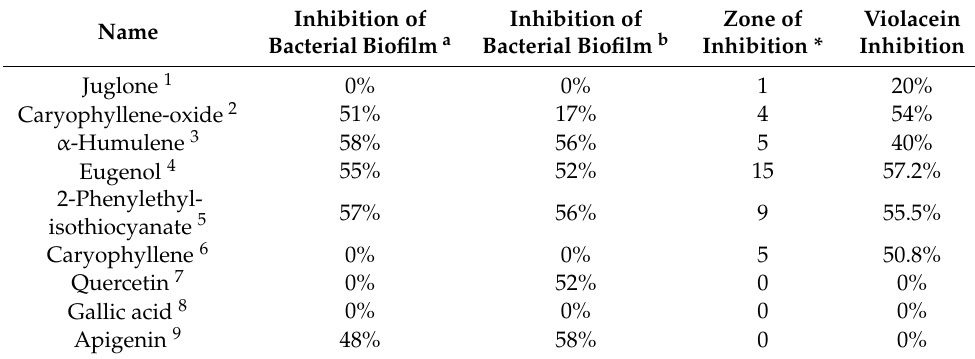
Table 7. Antibiofilm and anti-QS activity of tested